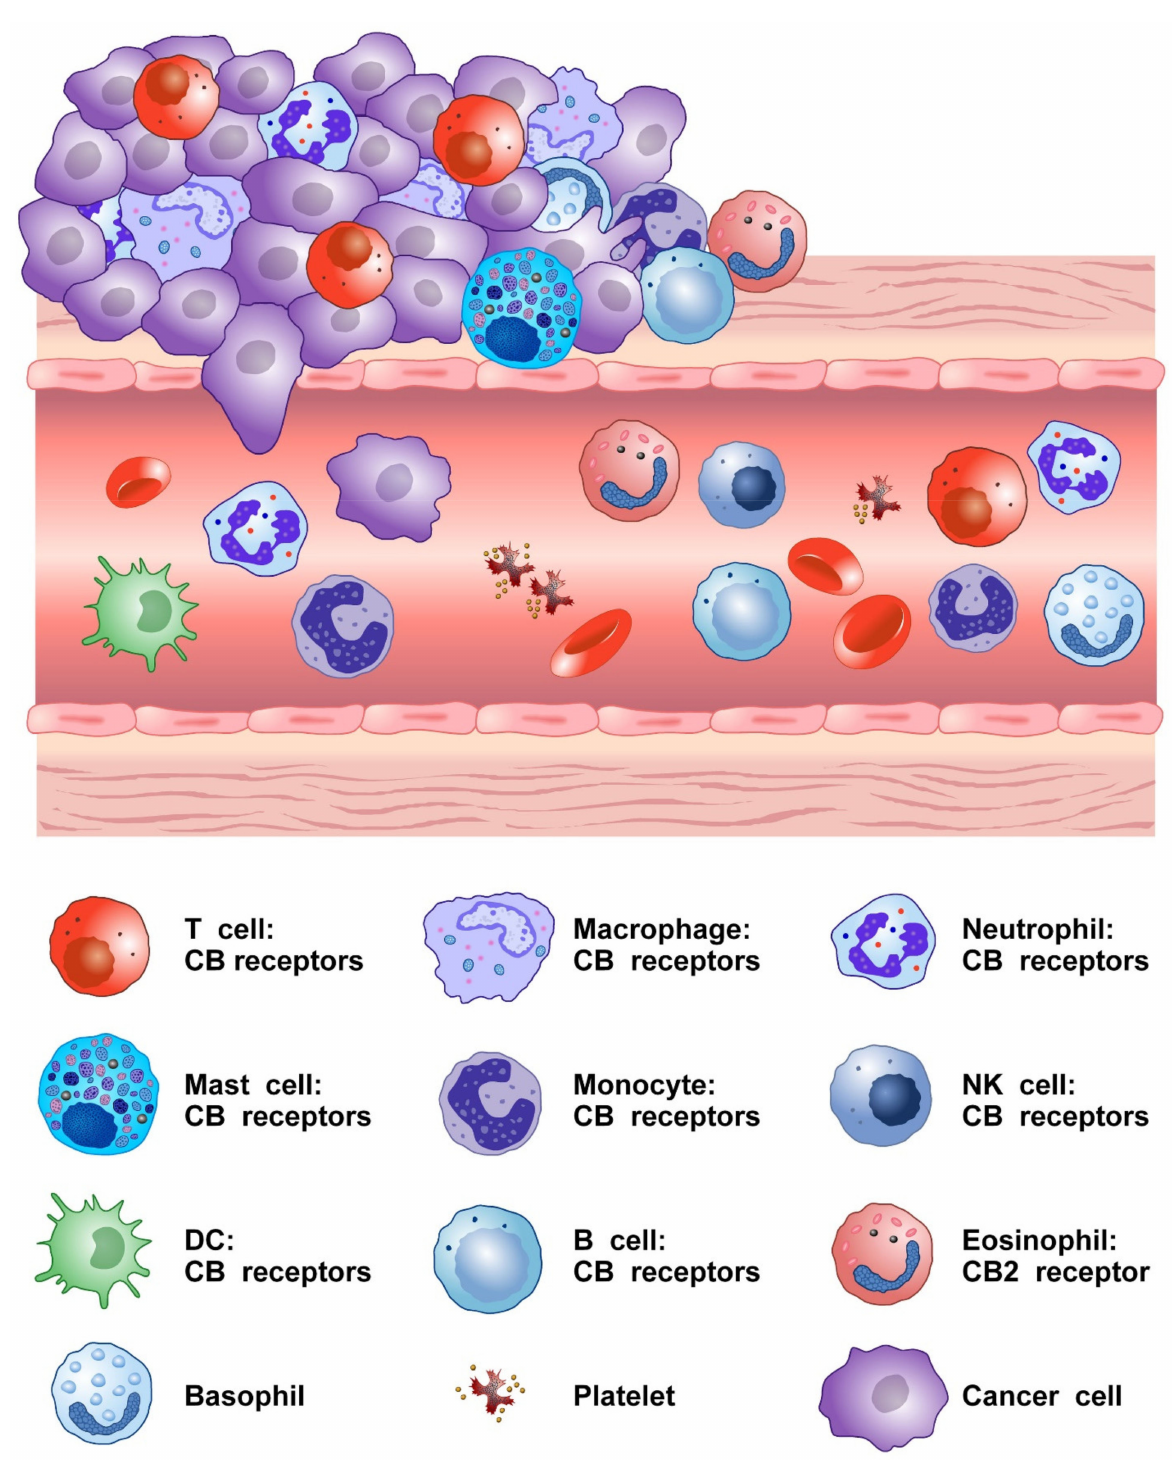
Figure 2. Schematic representation of cells of innate and adaptive immune system expressing CB receptors in the tumor mi-